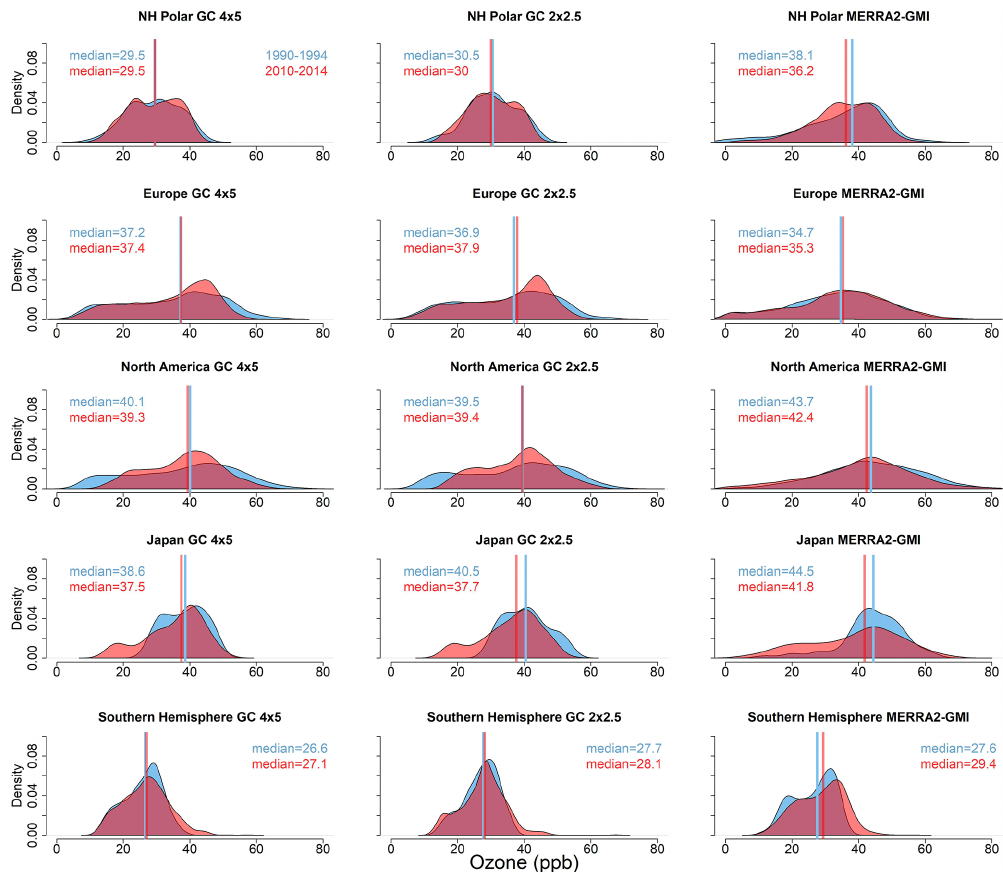
Figure 10. Distribution shifts in ozone concentrations (ppb) between 1990–1994 (blue) and 2010–2014 (red) at surface sites, divided into five regions. GC 4 × 5 refers to the GEOS-Chem v12.9.3 simulations at the 4 ◦ × 5 ◦ horizontal resolution, GC 2 × 2 . 5 is the same model at 2 ◦ × 2 . 5 ◦ , and MERRA2-GMI refers to the NASA GEOS GMI at ∼ 50km. Median concentrations are denoted with vertical lines, and the corresponding values are recorded